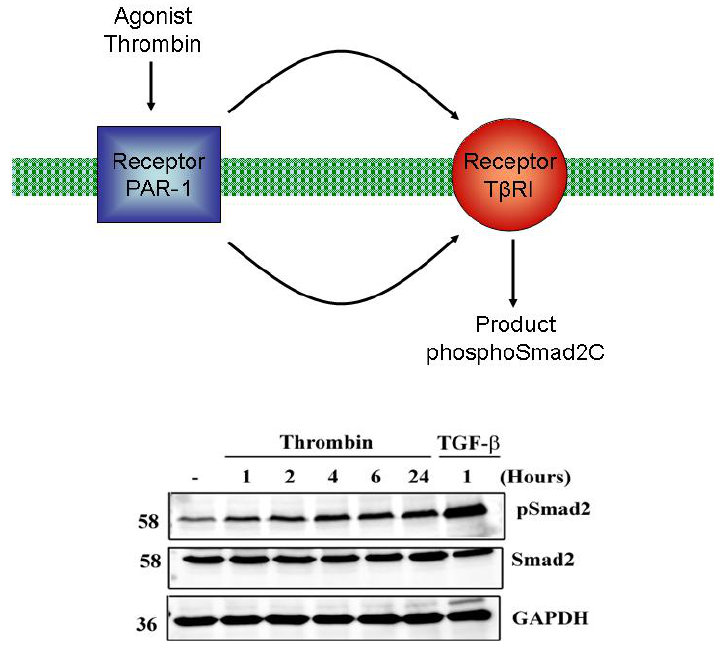
FIGURE 2. A novel example of G protein to protein Ser/Thr kinase receptor “transactivation”. Although the paradigm has been previously restricted to the GPCR transactivation of PTK receptors, it has recently been reported that GPCRs can transactivate the serine/threonine kinase activity of the TβRI receptor, leading to the rapid formation of phosphoSmad2. The data show that the level of pSmad2C is clearly increased by 1 h, and it is explained in the text that this response is blocked by both inhibitors of the thrombin receptor (PAR-1) and TβRI. (The research shown was originally published in Burch et al.[28]. © The American Society for Biochemistry and Molecular